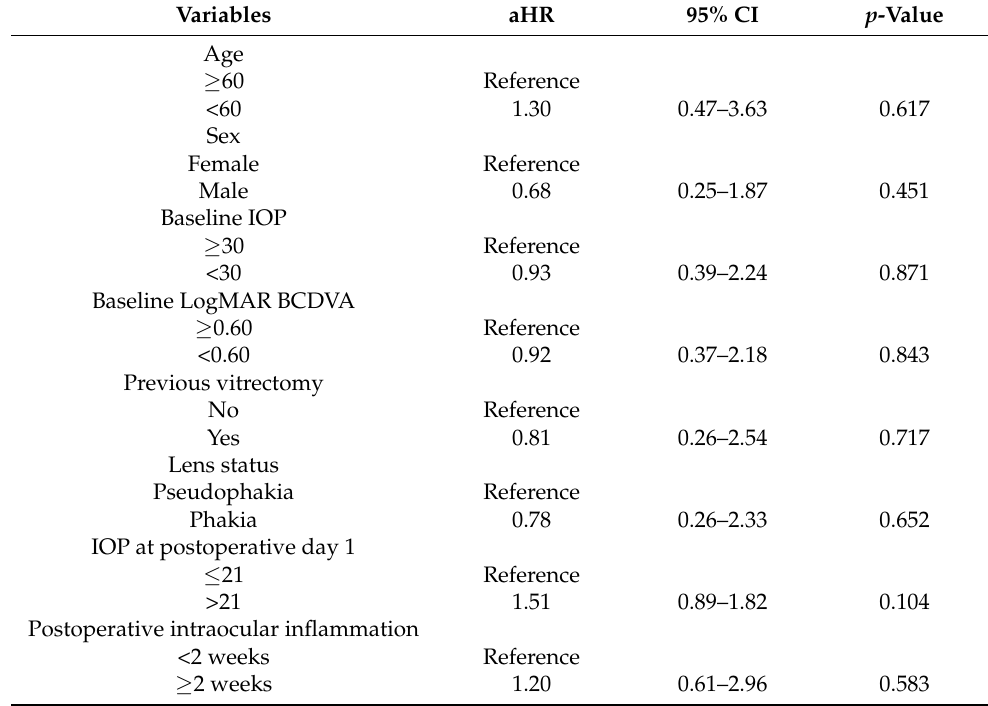
Table 6. Multivariate Cox proportional hazards models to investigate the significant independent predictors of treatment